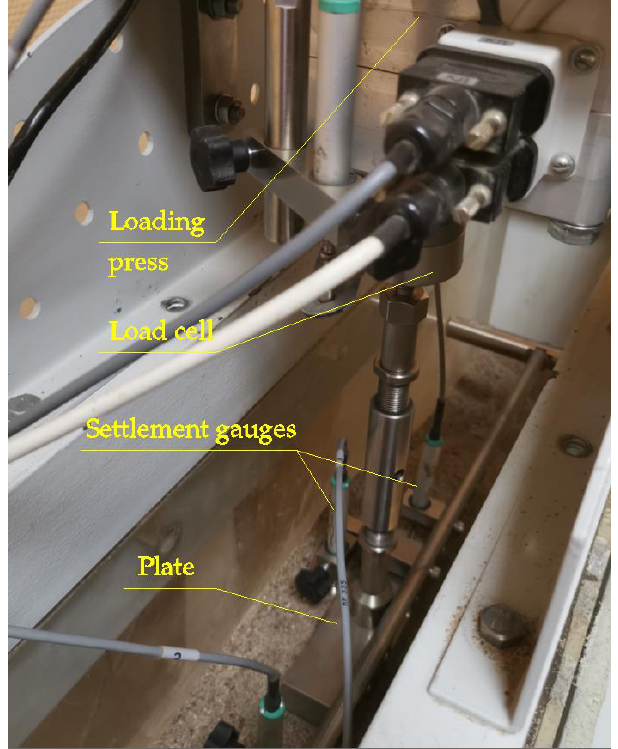
Figure 4. The laboratory plate-load-test measurement system used to perform the experiments. Settlements were measured with PZ-12-S-025 spring-type linear gauges (Gefran, Italy). Force measurements were performed using an MNC-2T load cell gauge (C.A.S., Republic of Korea). The buckets, datalogger, and software were produced by GeoTech (Perm, Russia).